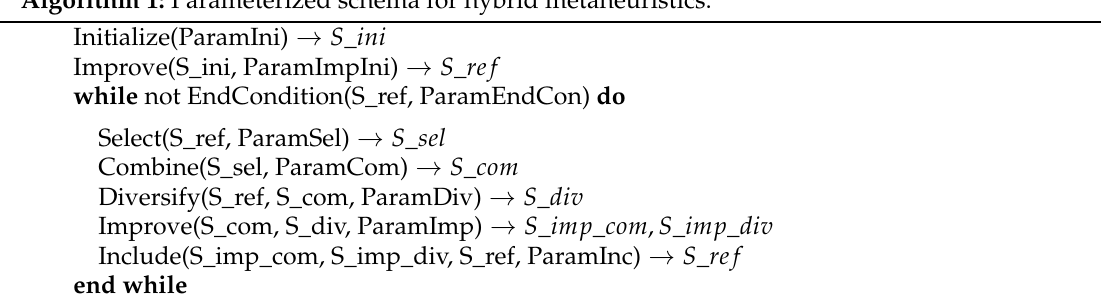
Algorithm 1: Parameterized schema for hybrid